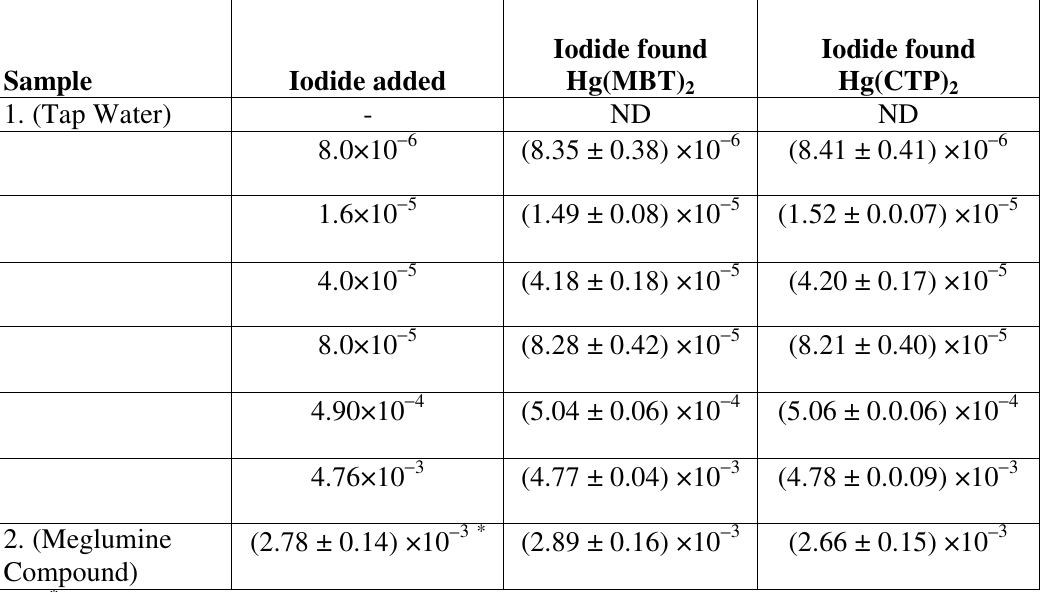
Table 4. Application of the Electrodes Based on Hg(MBT) 2 and Hg(CTP) 2 Carriers for Determination of Iodide Added to Tap Water and a Drug Preparation samples (All Concentrations are in